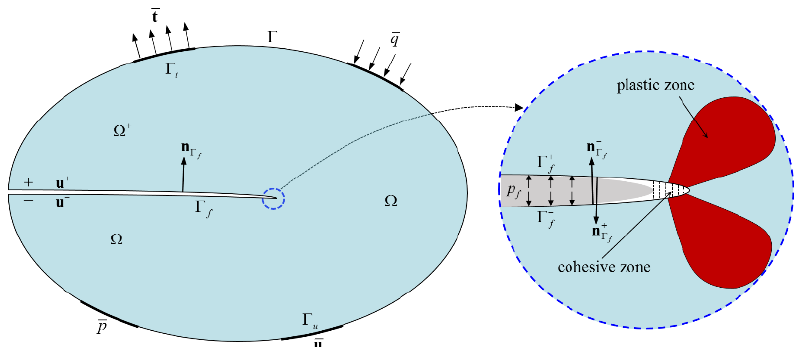
Figure 1. Physical model of elasto-plastic hydraulic fracture propagation in deep reservoirs.